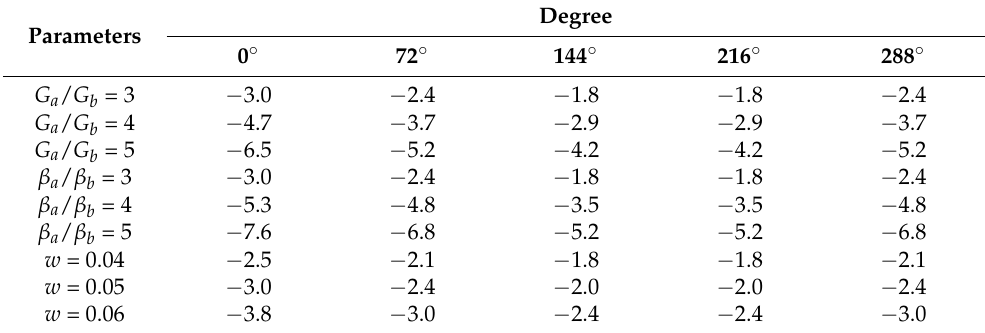
Table 2. The interfacial normal stress of each corner of the pentagonal hole with different parameters.